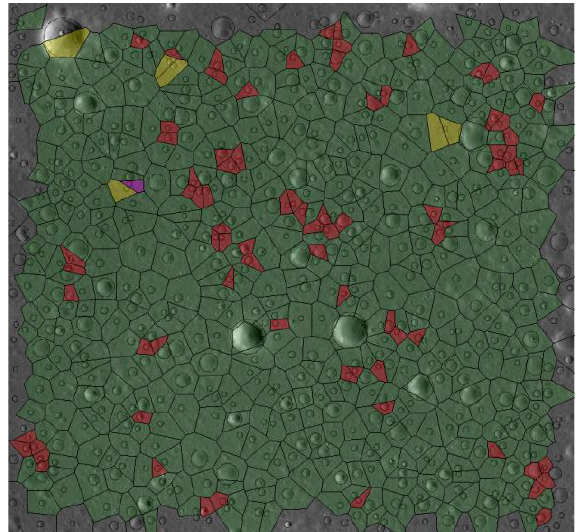
Figure 3. Visualized results of applying SCD algorithm to Kayguya TC image data of the floor of lunar crater Tsiolkovsky. Red areas correspond to detected secondary crater candidates, green areas to detected primary crater